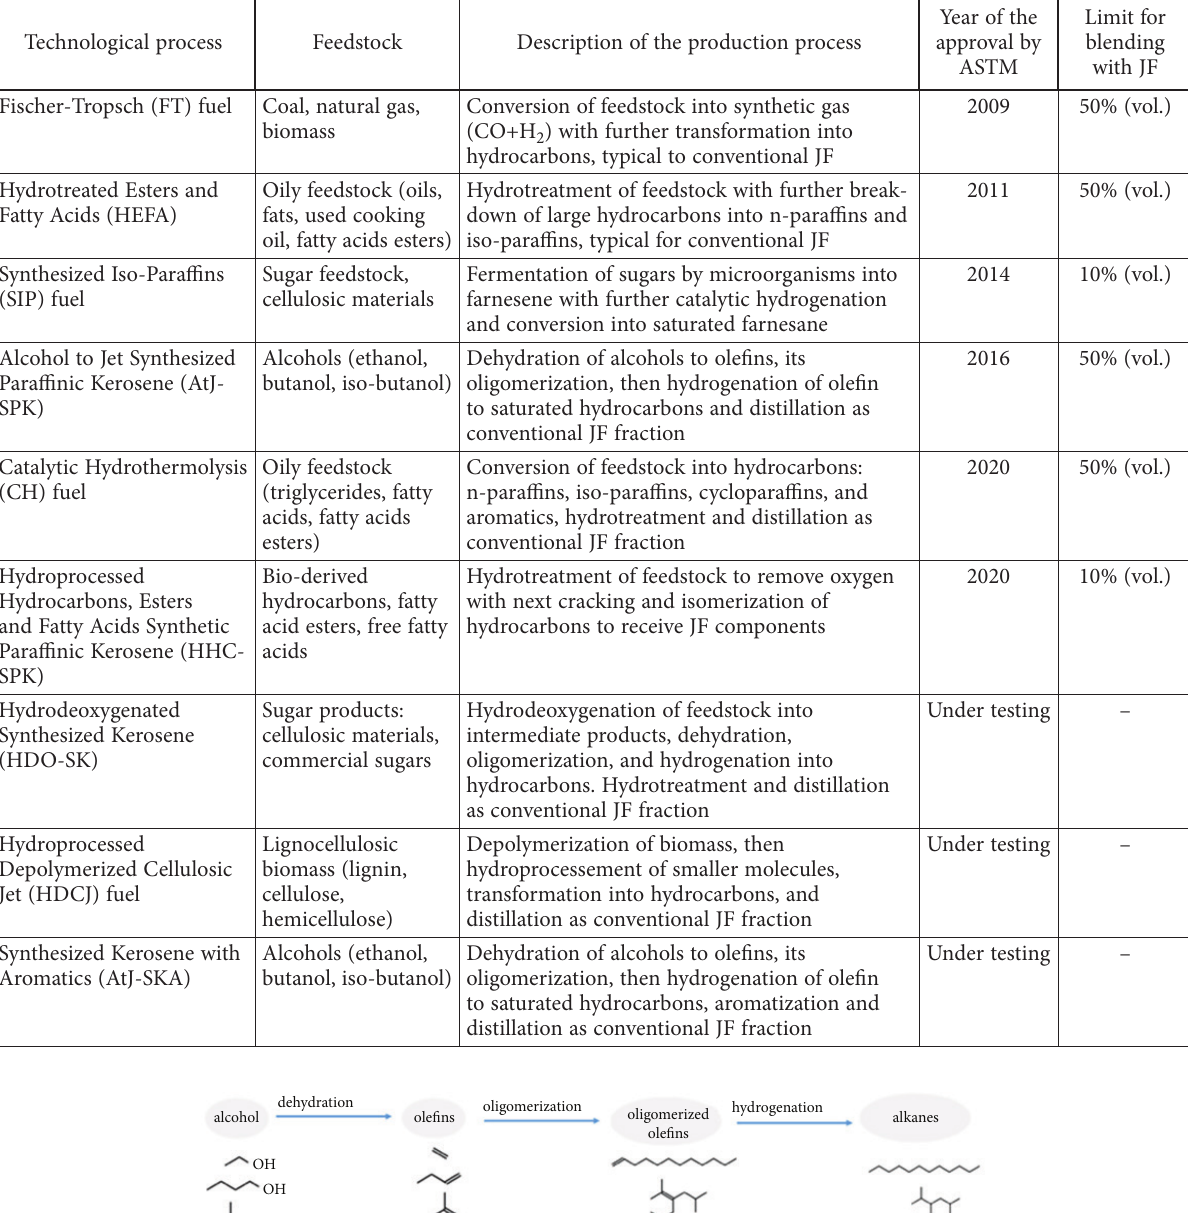
Table 1. Overview of technologies of SAFs production (source: Commercial Aviation Alternative Fuels Initiative , 2022)